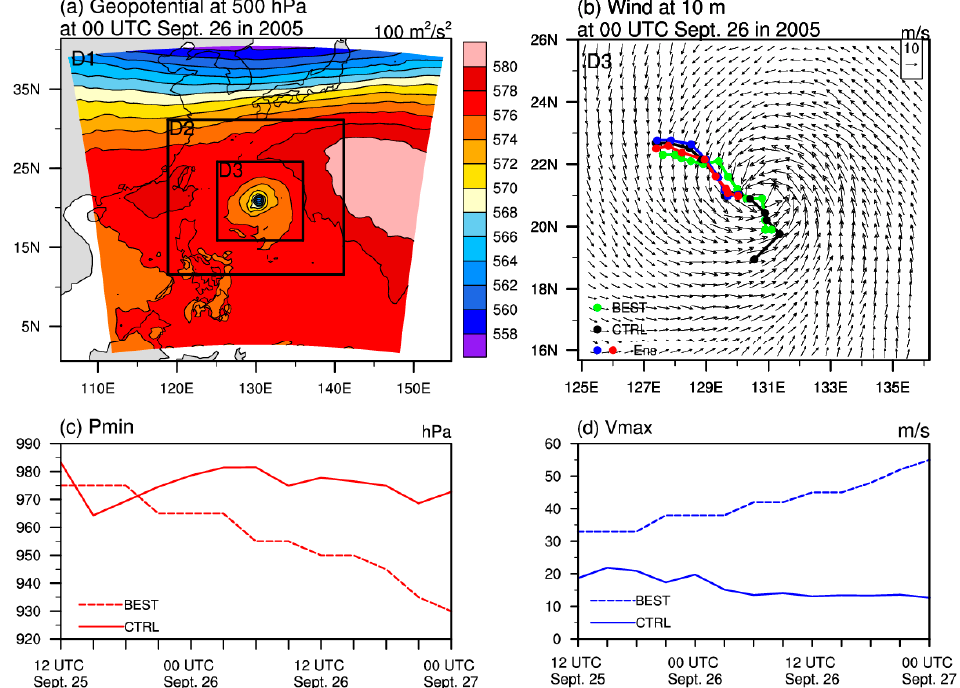
Figure 1. Simulated ( a ) geopotential, ( b ) wind and tracks, ( c ) Pmin, and ( d ) Vmax of Typhoon Dujuan (201521) in the weather research and forecasting (WRF) model. Blue and red lines in ( b ) denote the tracks in two ensemble forecast members with the most deviation from the simulation without any perturbations (CTRL).